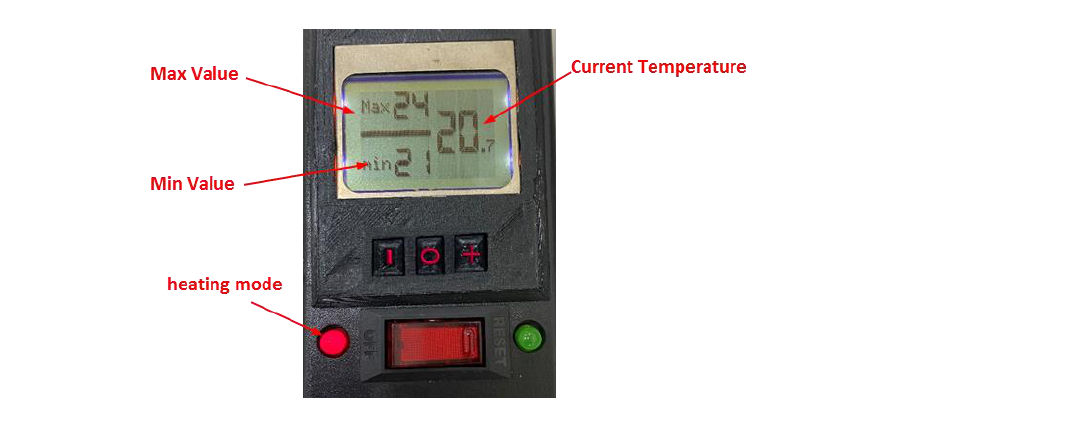
Figure 7. Heating mode example. It is currently set to heating mode, where the high temperature value is 24 °C, the low temperature value is 21 °C and the current temperature is 20.7 °C.